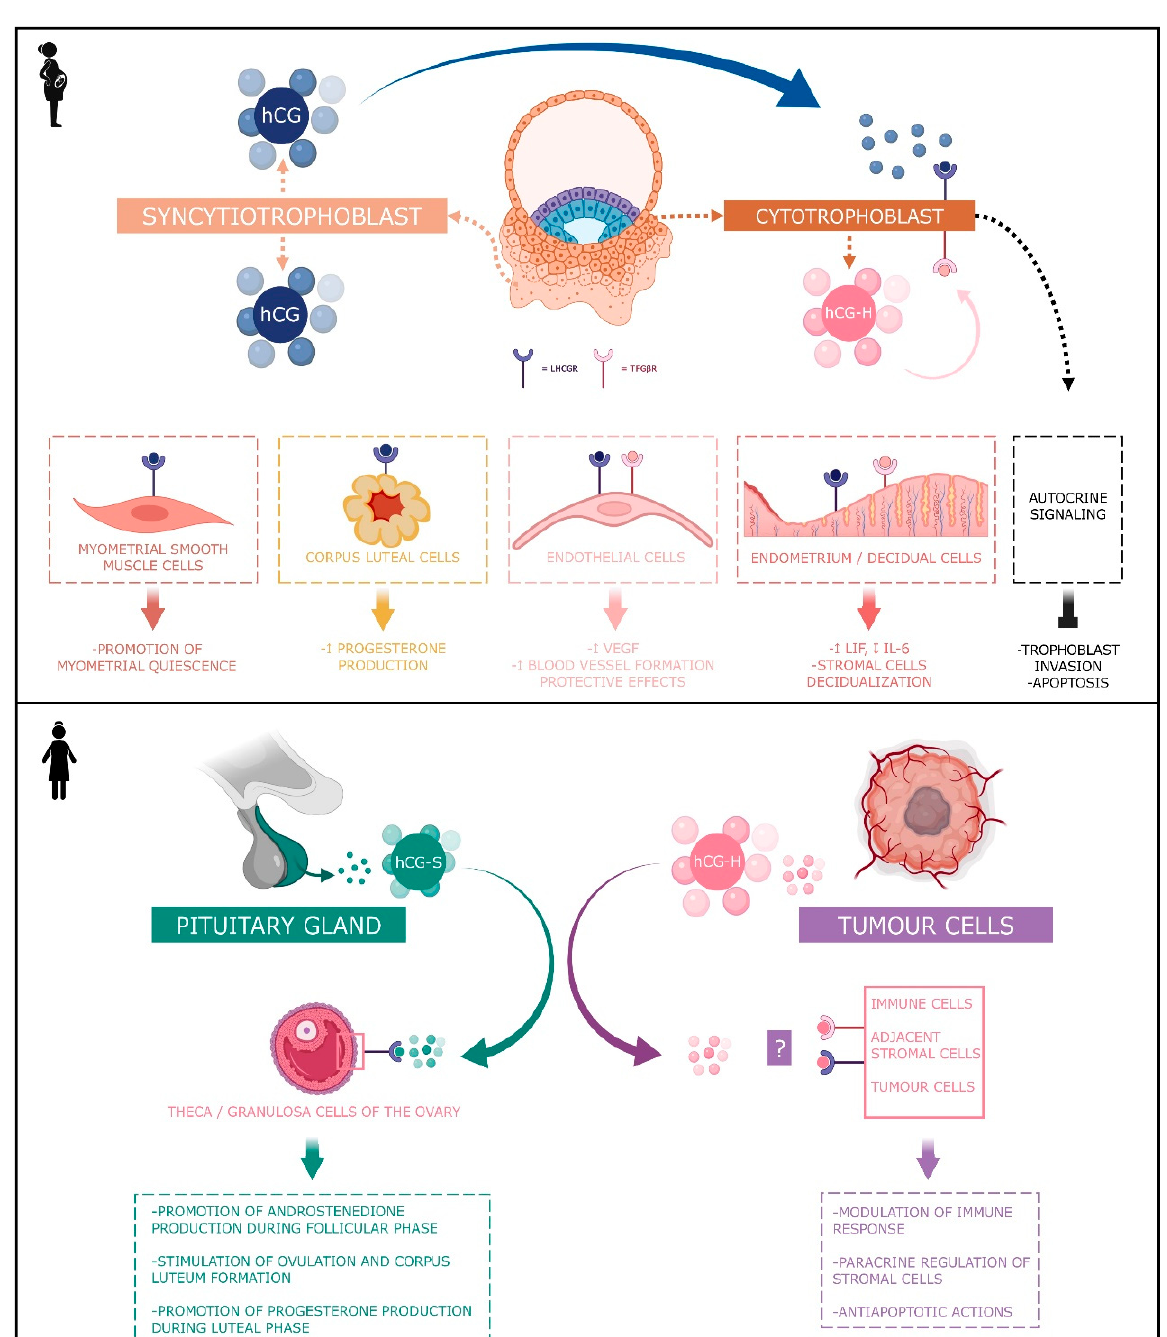
Figure 2. Schematic view of the actions of different forms of hCG during pregnancy and in non- pregnant woman. The classical form of hCG is schematized by a blue dot, the hyperglycosylated by a pink dot and the sulphated form of hCG by a green dot. The blue receptor is the LHCGR and the pink receptor is the TGF β R.